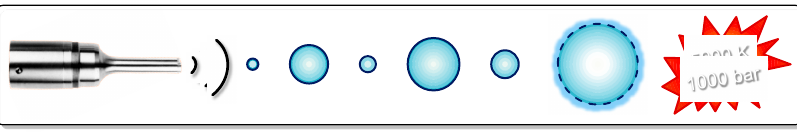
Figure 1. Growth and collapse of microsized bubbles in a liquid submitted to ultrasonic irradiation.